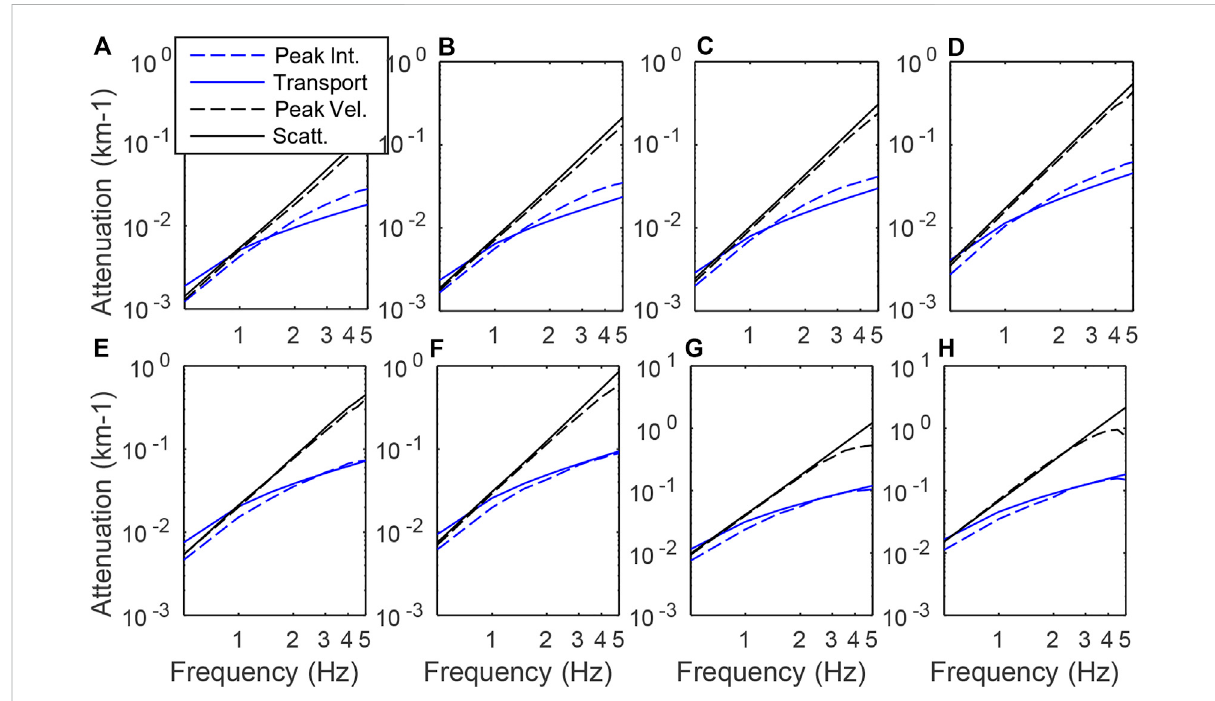
FIGURE 14 Peak intensity attenuation (dashed blue line) and comparison with transport mean free path (solid blue line), peak velocity attenuation of the coherentwave(dashedblackline)andscatteringmeanfreepath(solidblackline).Transportandscatteringmeanfreepathsplotscorrespondtotheir analytical solutions. Attenuation of the peak intensity is obtained from the ensemble average of the 180 realizations and the peak velocity correspondstotheensemble-spaceaveragecoherentwave fi eld (A – D) cases ε =5%and (E – H) cases ε =10%. (A,E) correspondtothecase ν =1, (B,F) to ν = 0.8, (C,G) to ν = 0.67 and (D,H) to ν =